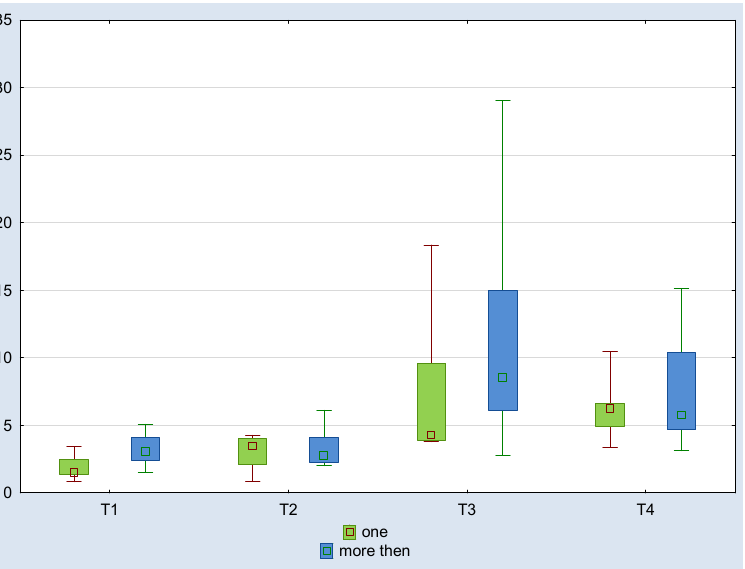
Figure 3. Free cortisol level in saliva of mares competing in one and more qualifying paths, median, percentiles and Kruskal–Wallis test (one: KW-H(3.24) = 13.94 p = 0.0030; more than one: KW-H(3.48) = 26.2968 p = 0.00001). The variables after the endurance–condition test are characterized by right-handed asymmetry. Explanations as in Table 1.